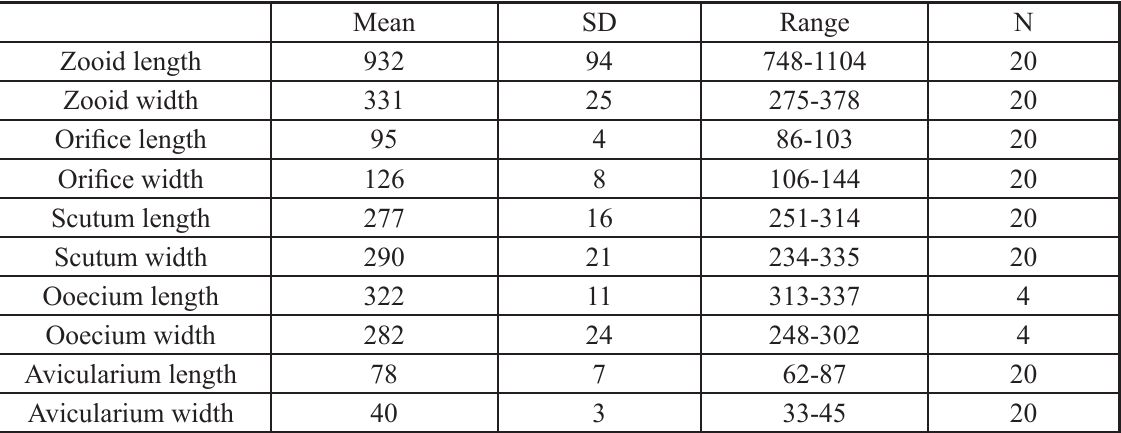
Table 1. Measurements (in µm) of skeletal characters of Notoplites saojorgensis sp. nov., taken from the holotype (MnHn 4163). SD = standard deviation, n = number of